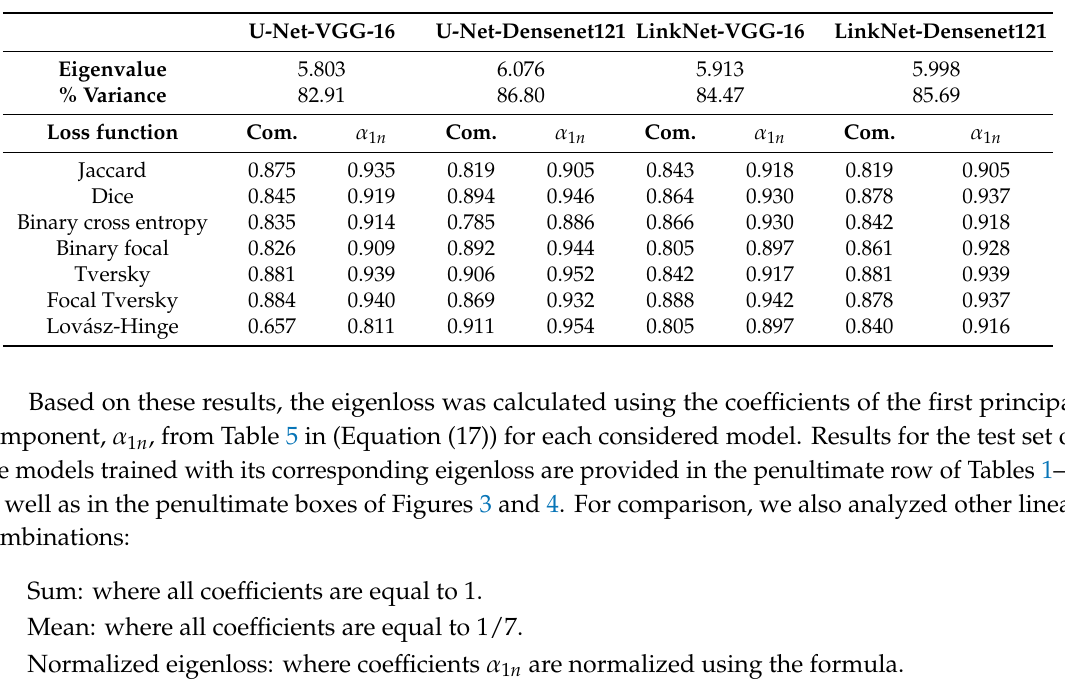
Figure 3. Boxplot for accuracy for the different models and loss functions analyzed. Table 5. PCA results. Com: Communality; α 1